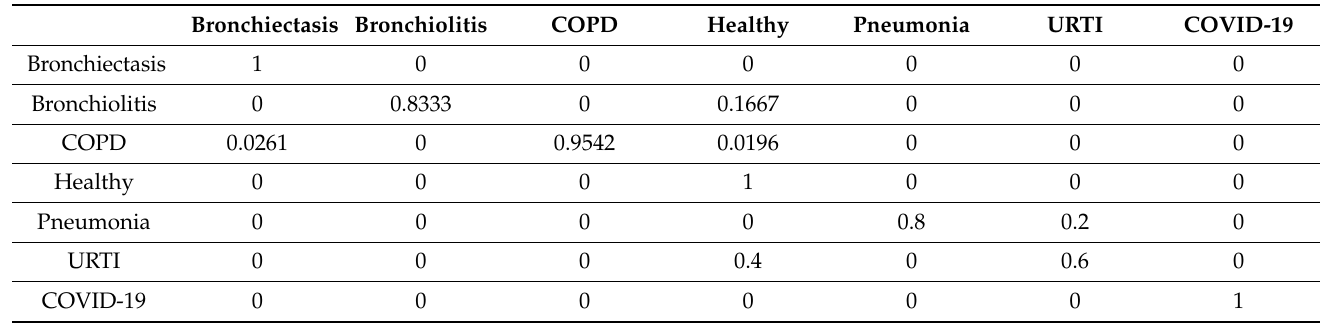
Table 23. Confusion matrix of the proposed ensemble model for D5, i.e., the combination of ICBHI and Coswara breathing datasets.